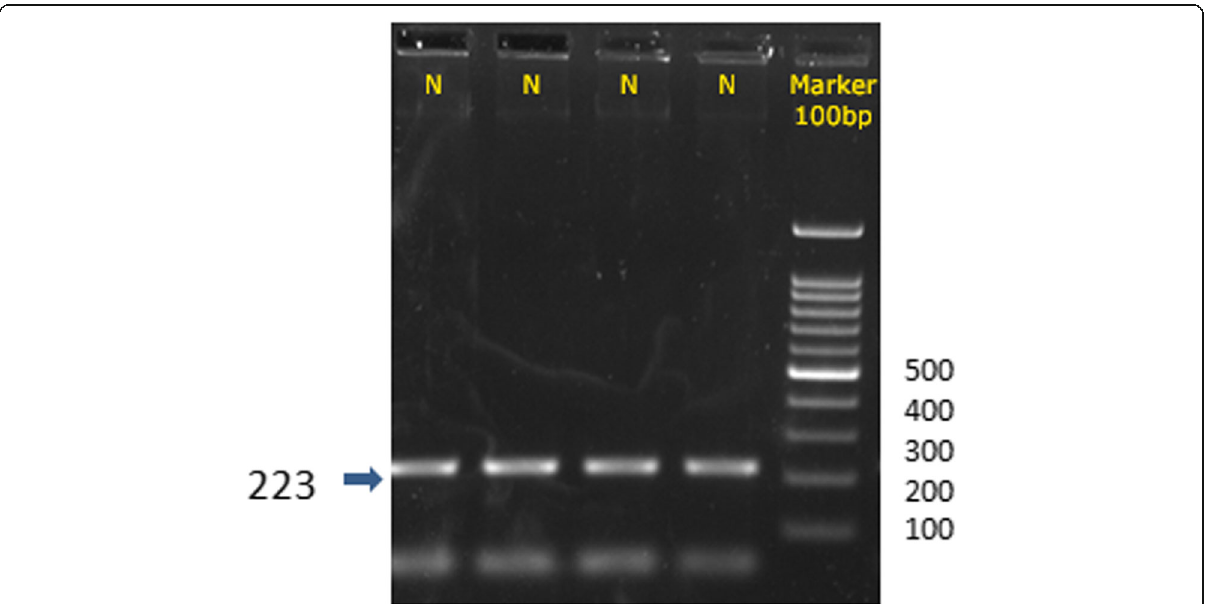
Fig. 2 Restriction digestion by Bst U1 of SLC1A3 C869G amplicon of representative individuals. This polymorphism was not found in the cohort of individuals selected and a full length amplicon of 223 bp, is seen in all the lanes. The cases and controls with reference to stress and depression showed no heterozygotes in control as well cases